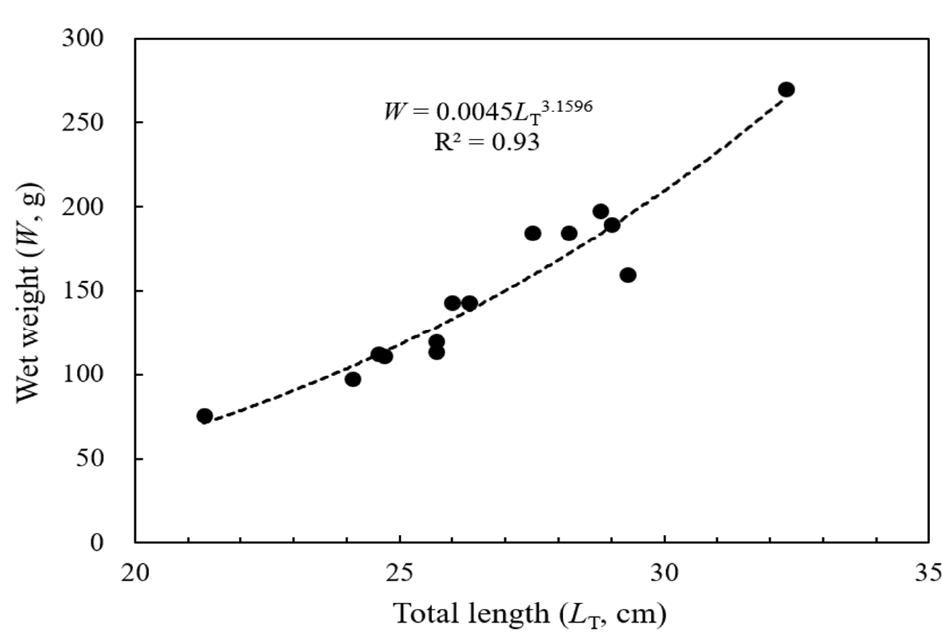
Figure 1. The relationship between total length ( L T , cm) and wet weight ( W , g) in the Pacific herring used to measure TS.